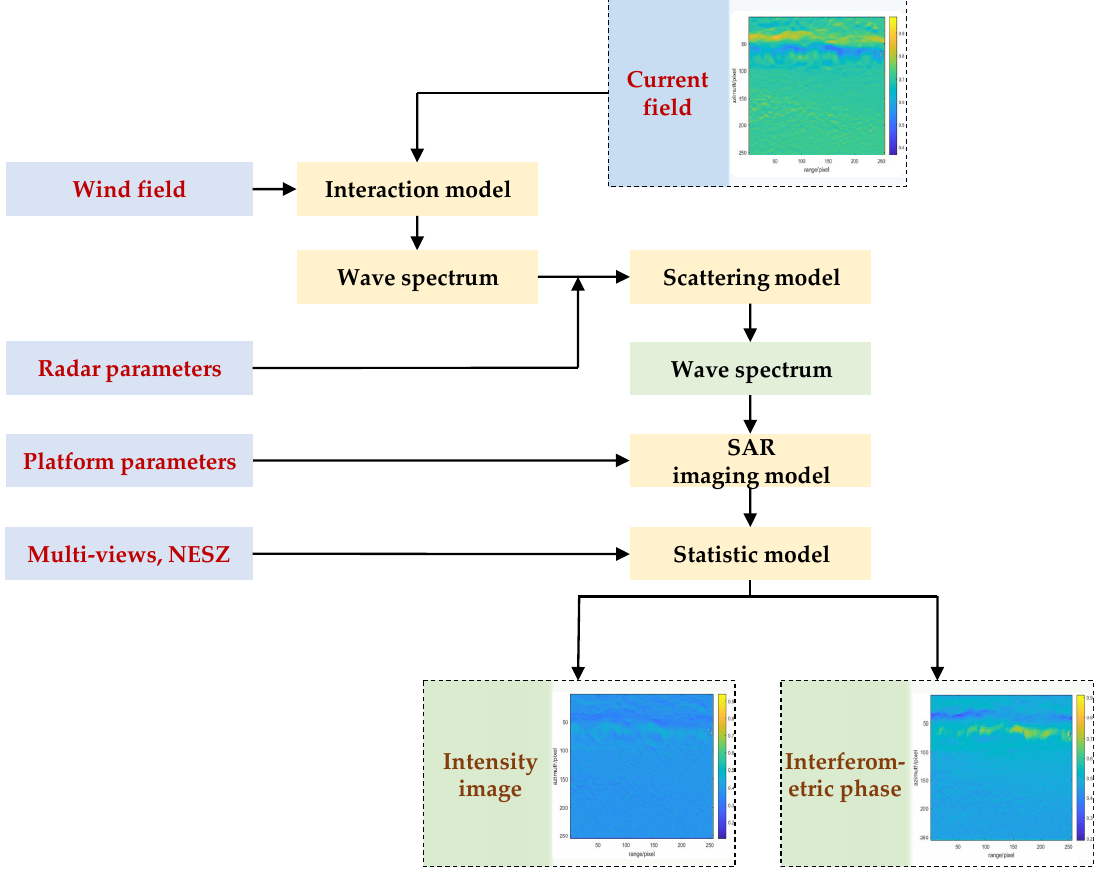
Figure 3. The current chart of interferometric phase generation based on M4S software.